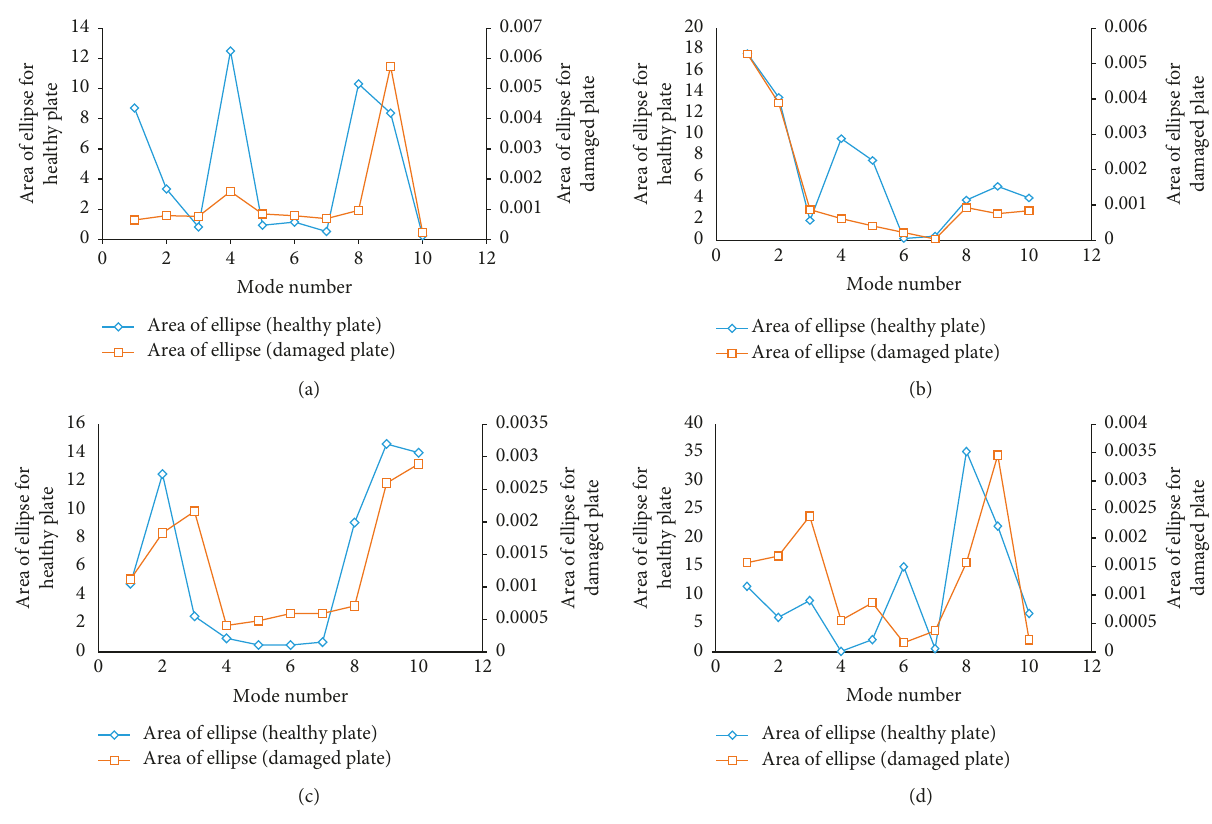
Figure 4: Variation in the area of the ellipse for plates (a) A1, (b) A2, (c) A3, and (d)